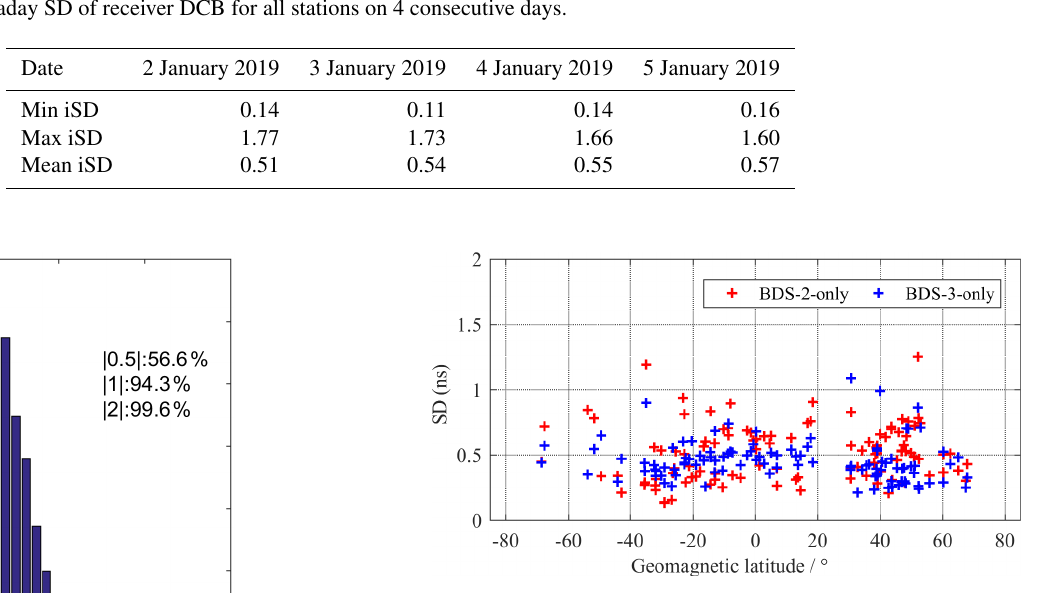
Figure 9. The mean intraday SD of receiver DCB for all station in 30d by using BDS-2-only and BDS-3-only observations.